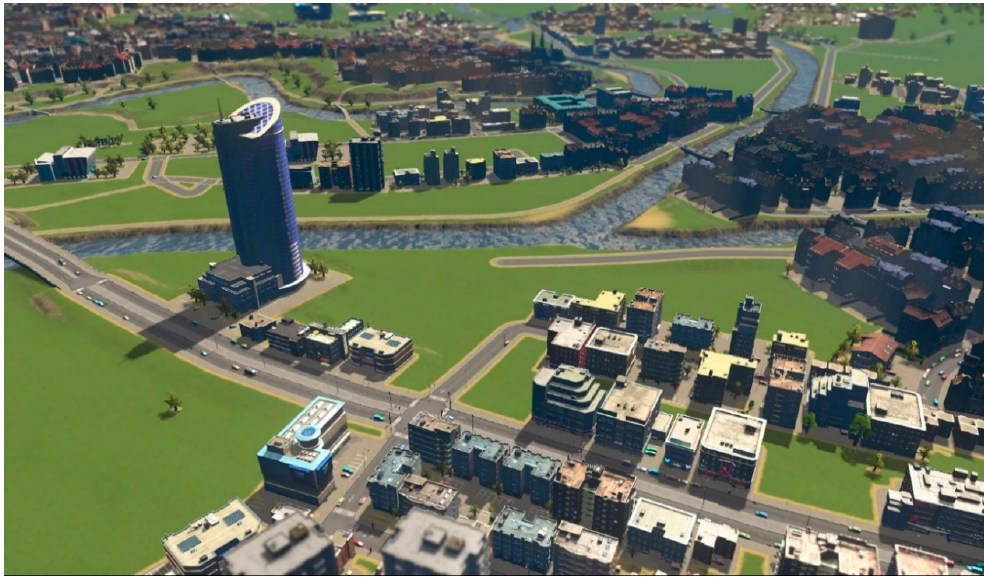
Figure 9. A playable model of Olomouc in Cities: Skylines (river view).